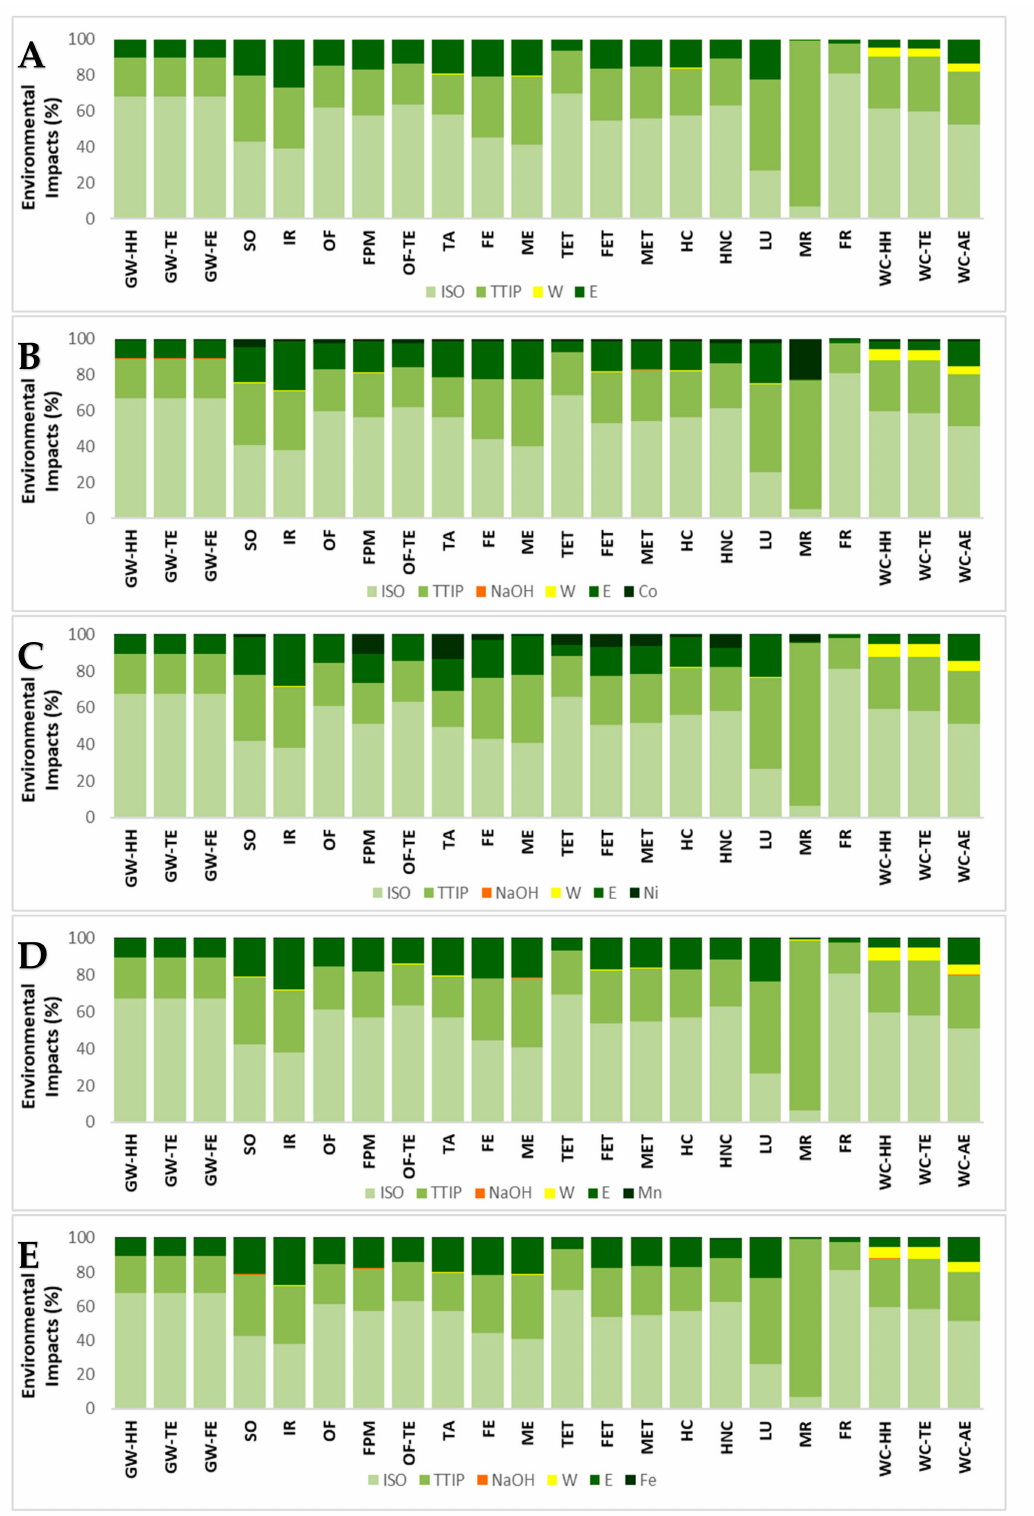
Figure 1. Relative environmental impacts of synthesis of the undoped TiO 2 photocatalyst ( A ), Co-doped TiO 2 photocatalyst ( B ), Ni-doped TiO 2 photocatalyst ( C ), Mn-doped TiO 2 photocatalyst ( D ), and Fe-doped TiO 2 photocatalyst ( E